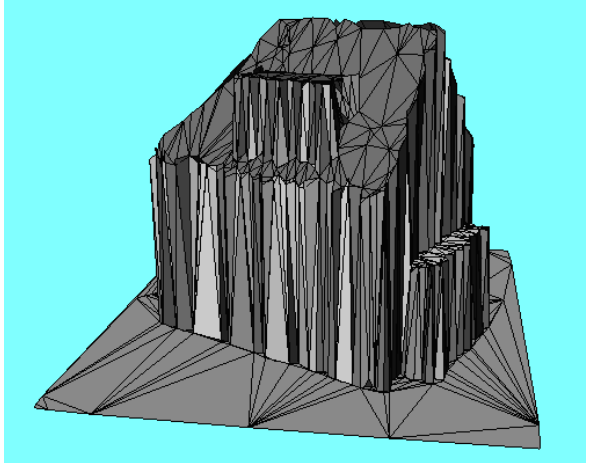
Figure 4. Result of data reduction on the TIN of Figure 1.